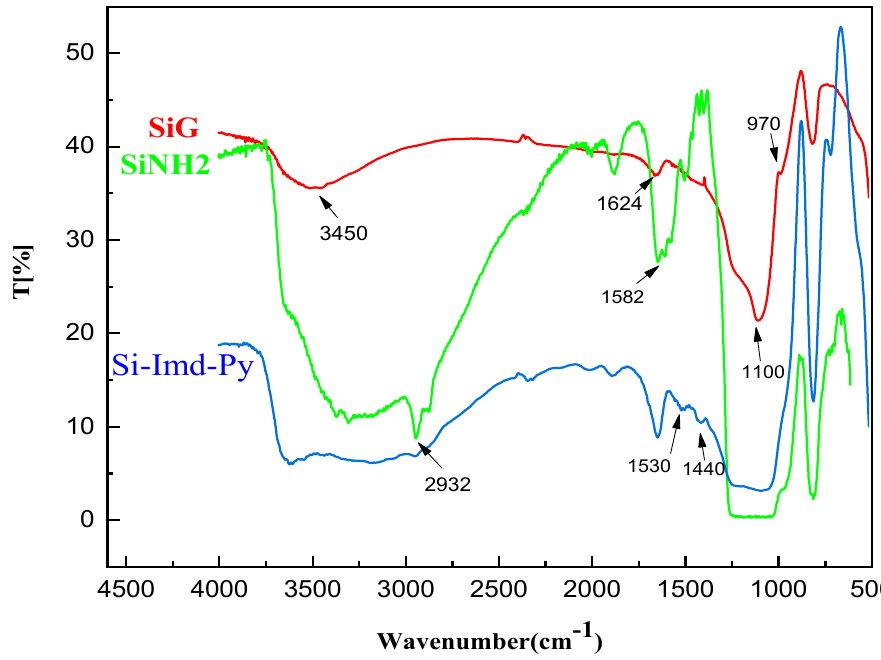
Figure 1. FTIR spectra of SiNH2 and Si-Imd-Py (before and after desorption).